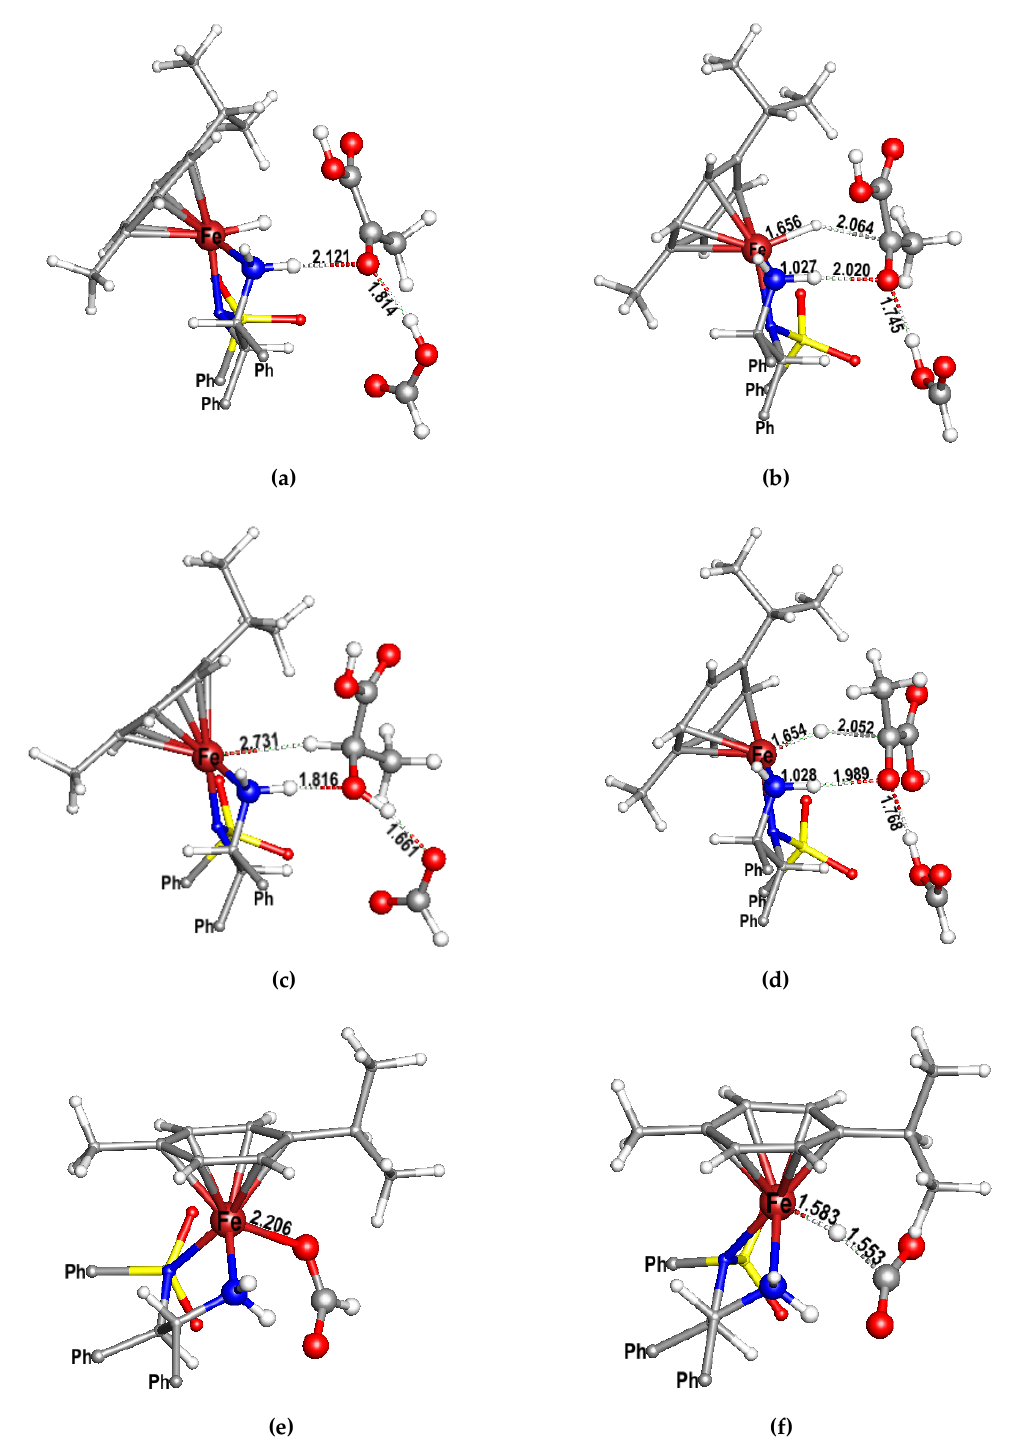
Figure 2. Optimized structures of ( a ) pro -2 R , ( b ) TS 2,3- R (227 i cm − 1 ), ( c ) 3 R , ( d ) TS 2,3- S (140 i cm − 1 ), ( e ) 5′ , and ( f ) TS 5,1 (520 i cm − 1 ). Bond lengths are in Å. Phenyl groups are omitted for clarity.